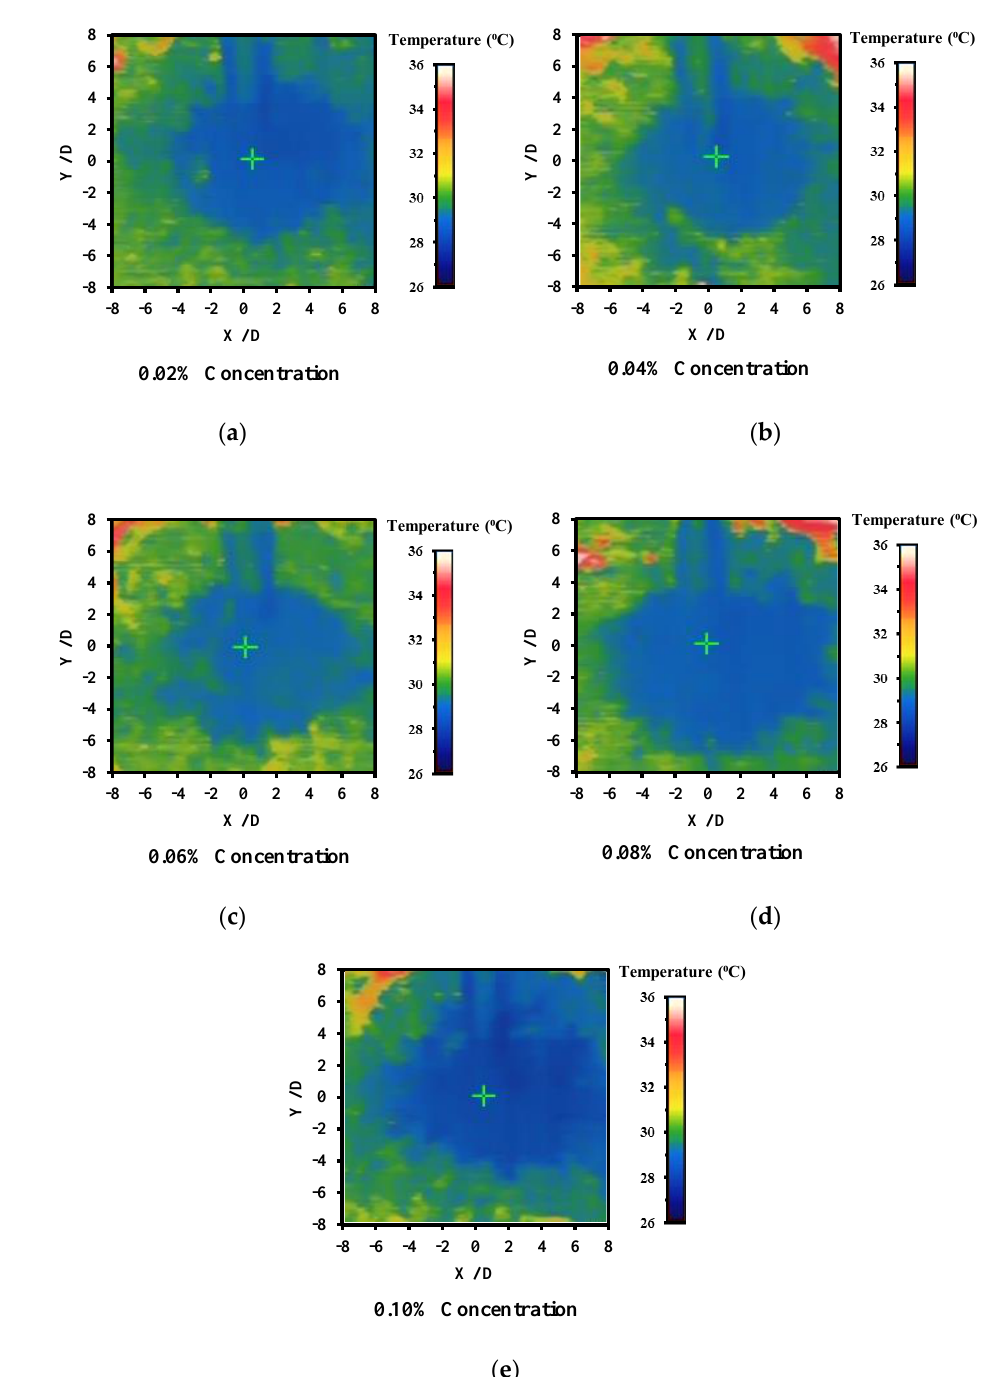
Figure 17. Thermography images of heated plate focusing on stagnation zone of the impinging jet by using hybrid nanofluids at mass fraction ( a ) 0.02%, ( b ) 0.04%, ( c ) 0.06%, ( d ) 0.08%, and ( e ) 0.10%.